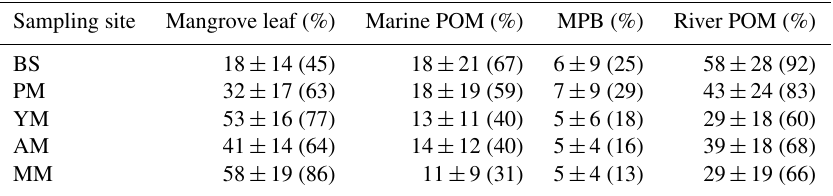
Table 2. Contribution (%) of end-member sources to sediment organic matter. POM: particulate organic matter, MPB: microphytobenthos, AM: adult mangrove, MM: mature mangrove, PM: pioneer mangrove, and YM: young mangrove. Bare sediment or BS was set as reference level. Mean ± SD (mean at 95% confidence